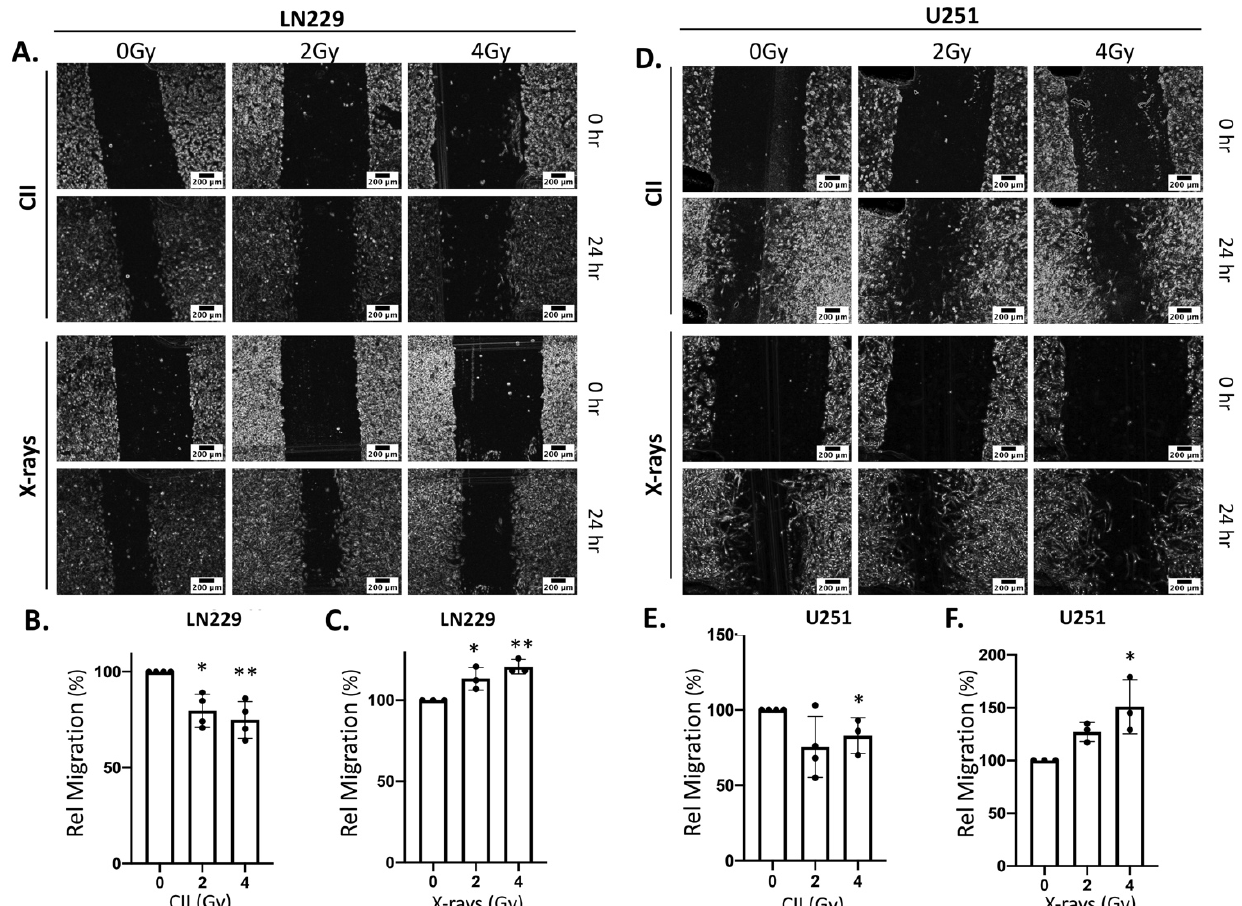
Figure 4. CII reduces while X-rays enhances migration of LN229 and U251 glioma cells: Representa- tive images of the ( A ) LN229 and ( D ) U251 glioma cell migration after irradiation with CII or X-rays as analyzed by scratch assay (scale bar in black = 200 μm); ( B ) Bar graph showing the relative migration of LN229 irradiated with CII as derived from panel ( A ); ( C ) Bar graph showing the relative migration of LN229 cell irradiated with X-rays as derived from panel ( A ); ( E ) Bar graph showing the relative migration of U251 cell irradiated with CII as derived from panel ( D ); ( F ) Bar graph showing the relative migration of U251 cell irradiated with X-rays as derived from panel ( D ). Each experiment was performed in duplicate. Each symbol in the bar graph represents an independent experiment. Data are represented as ± SD. Statistical analysis was performed by ANOVA with Bon- ferroni post-hoc test. p -values (* p < 0.05, ** p < 0.01).